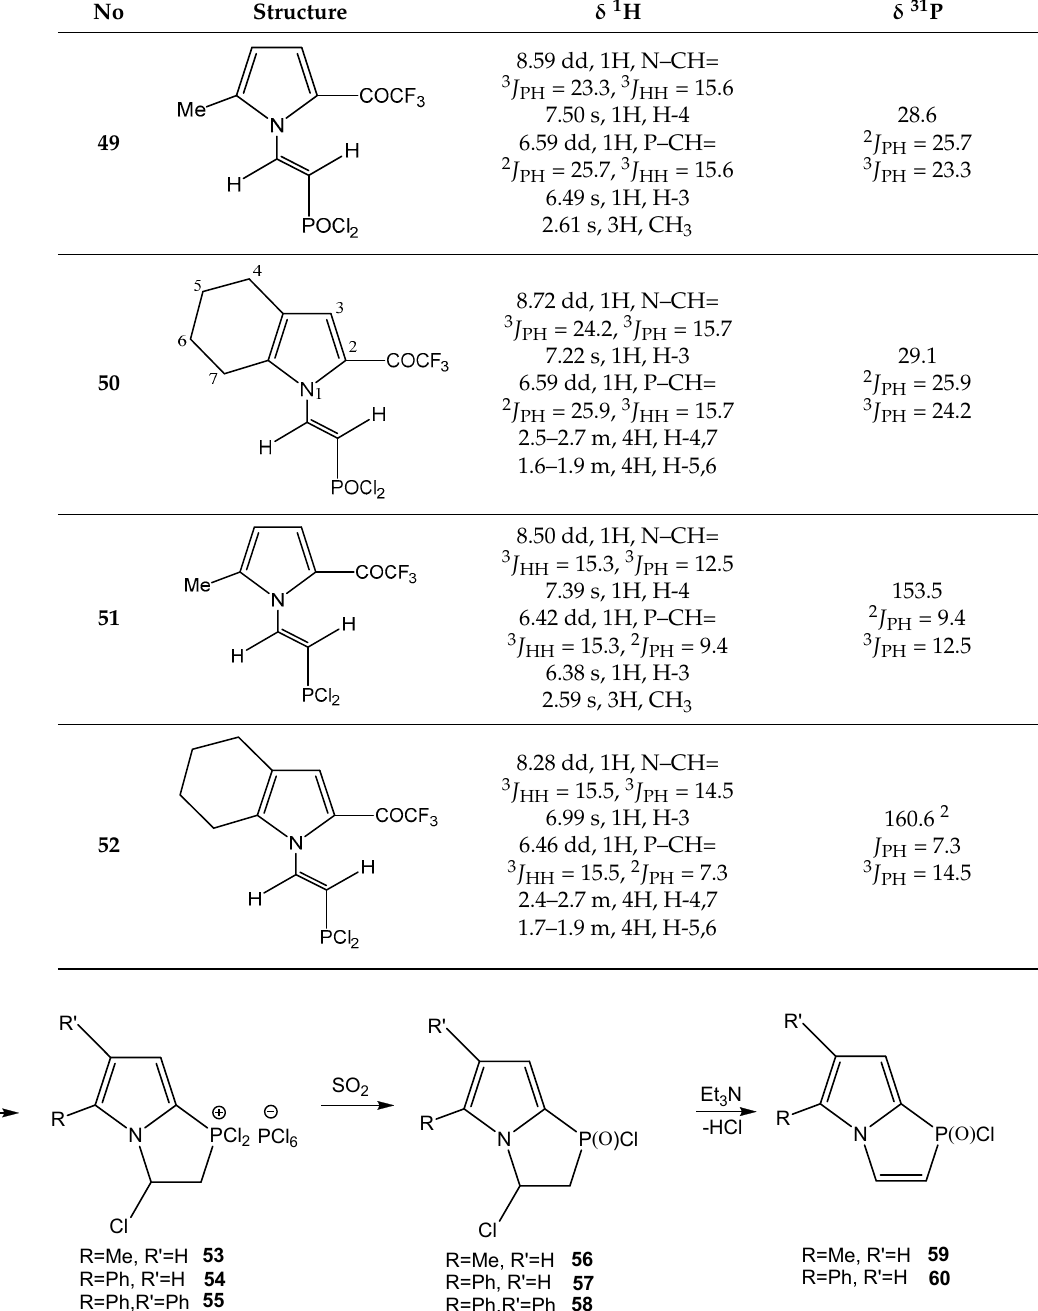
Table 16. 1 H, and 31 P NMR chemical shifts ( δ , ppm) and coupling constants ( J , Hz) of phosphorylated trifluoroacetylpyrroles (CDCl 3 ).